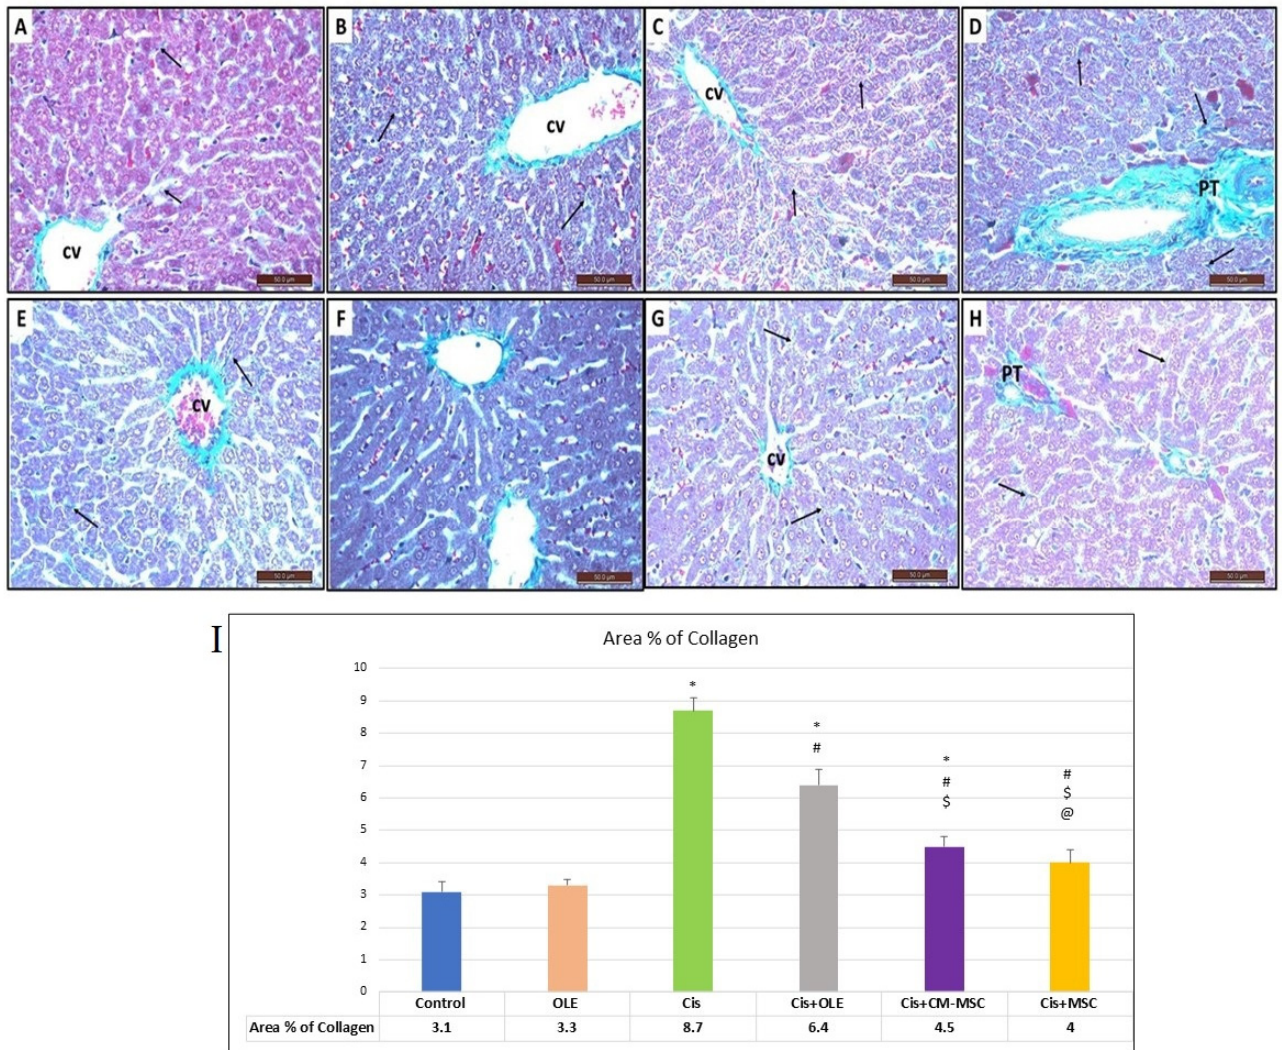
Figure 4. Photomicrographs of liver sections of all study groups stained with Masson Trichrome stain are showing collagen fibers distribution around the central vein (CV), portal triad (Pt), and in the connective tissue septa (arrow). ( A , B ): Control and OLE group, respectively. ( C , D ): Cis group. ( E , F ): Cis + OLE, Cis + CM-MSC groups, respectively. ( G , H ): Cis + MSC group. The expression of collagen fibers was more noticeable in the Cis group compared to the other groups. ×400. ( I ): The mean area percentage bar chart of collagen fibers in the sections of the liver. Mean ± SD was used to express the data of the experiment. 6 fields per section/rat. Significant in comparison to control group (*), Cis group (#), Cis + OLE group ($), and Cis + CM-MSC group (@); ( p < 0.05).